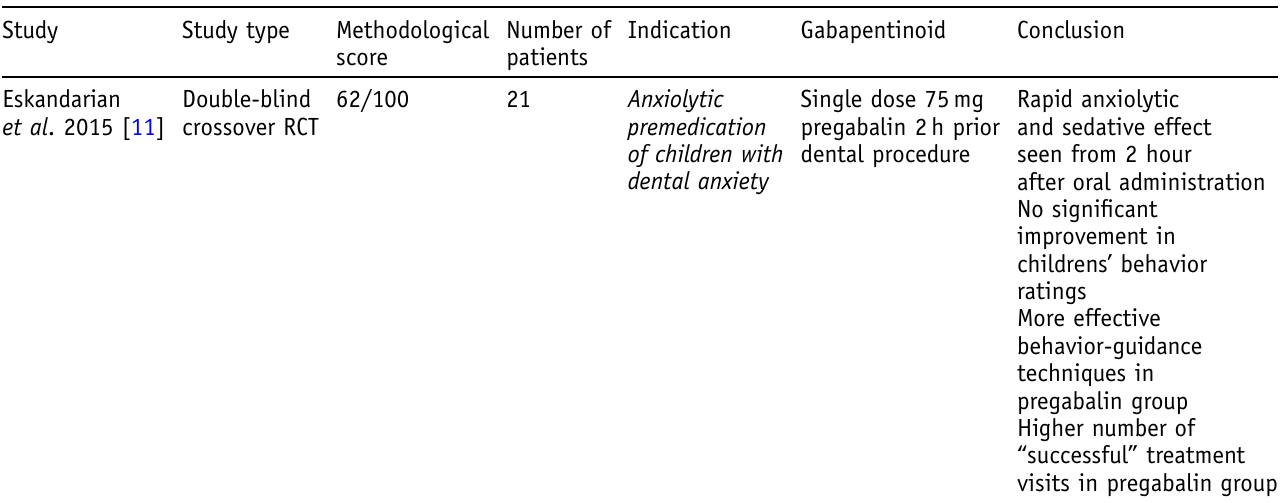
Fig. 3. Distribution of selected studies sorted by indication (N.B: 1 case series in common for both neuropathic pain and headache). Table I. Scoping review results (cid:1) Gabapentinoids in the management of dental